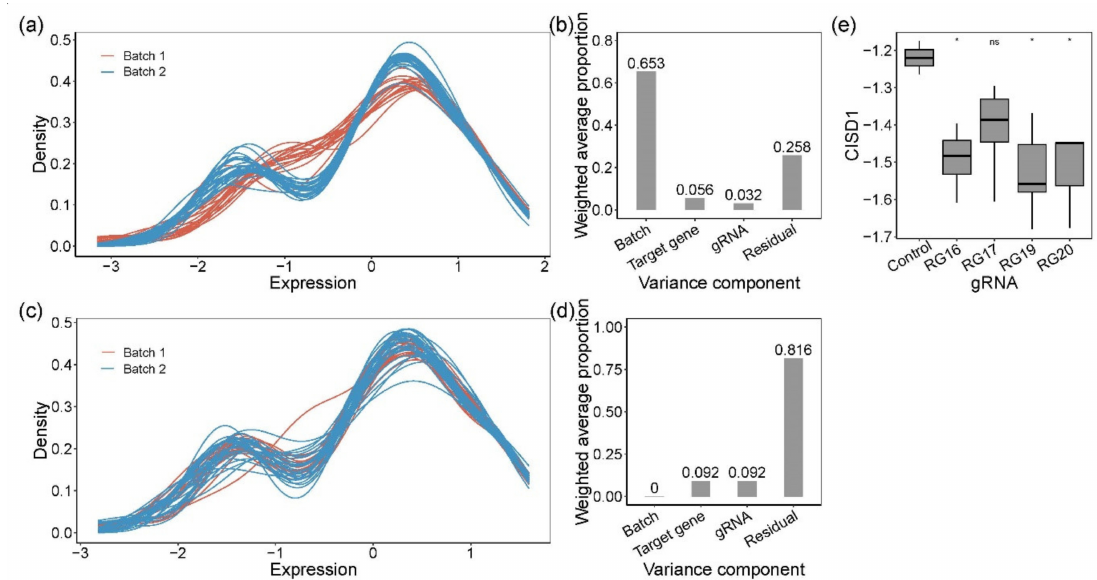
Figure 2. Quantification of gene expression by Fluidigm qRT-PCR and analysis of the variance components. Kernel density plot of standardized gene expression from each sample, color-coded by batches, before ( a ) and after ( c ) removing batch e ff ect. Before ( b ) and after ( d ) batch e ff ect correction, principal variance component analysis showed the weighted average proportion of each variance component: batch 65.3%, 0%, respectively; target gene 5.6%, 9.2%, respectively; gRNA 3.2%, 9.2%, respectively; residual 25.8%, 81.6%, respectively. All of the components explained variance captured by the first five principal components (99.1% and 99.1% of the total variance, respectively). ( e ) Expression of CISD1 . Pairwise t -tests were used to evaluate the di ff erence between CRISPR-Cas9-edited samples (RG16, RG17, RG19, and RG20) and negative controls. RG16, RG19, and RG20 were significantly di ff erent from the negative control. * denotes p -value < 0.05; ns, not